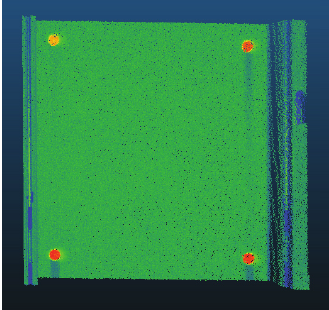
Figure 2. Intensity problems below retro-reflecting targets